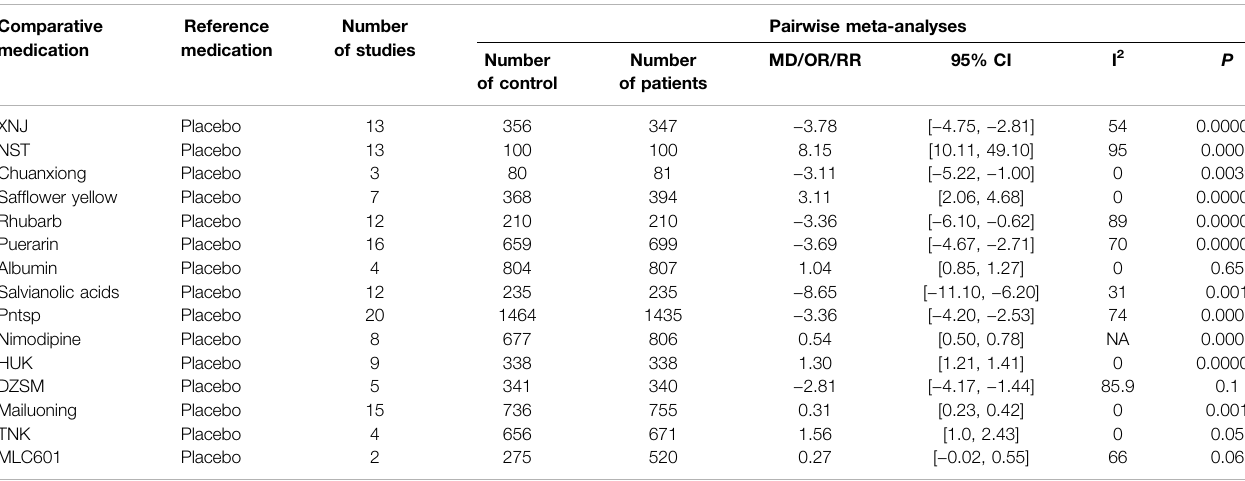
TABLE 6 | Results of pairwise meta-analyses for NFDs. Comparative